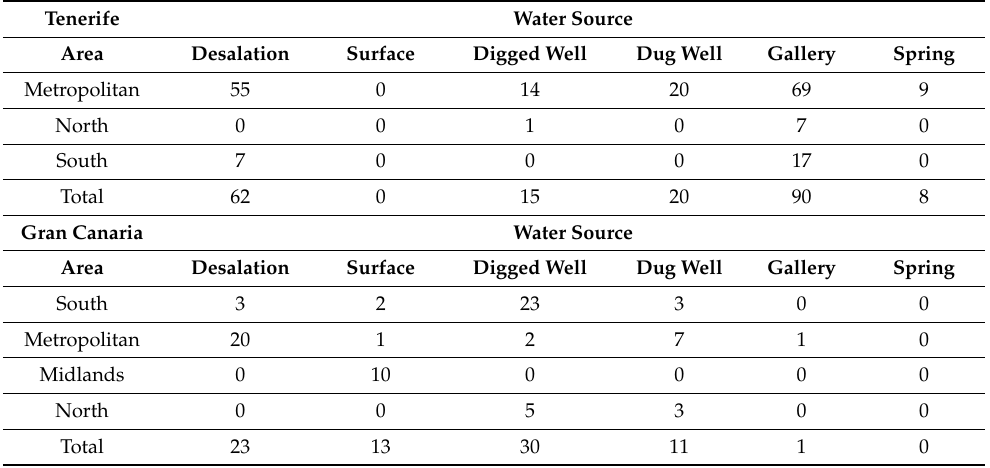
Figure 1. Canary Islands situation (obtained from Google Earth™ software (version 9.175, Google, Mountain View, CA, USA)). Table 2. Water sources of the collected samples from Tenerife and Gran Canaria